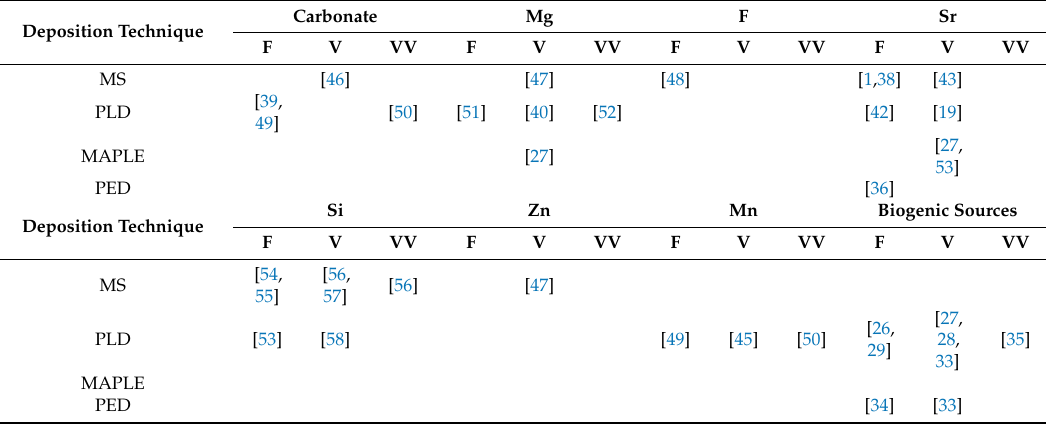
Table 1. Available literature on ion-substituted coatings realized by thin film deposition techniques. F: Only data relative to coating fabrication and characterization available; V: Data from biological in vitro test available; VV: Data from biological in vivo test